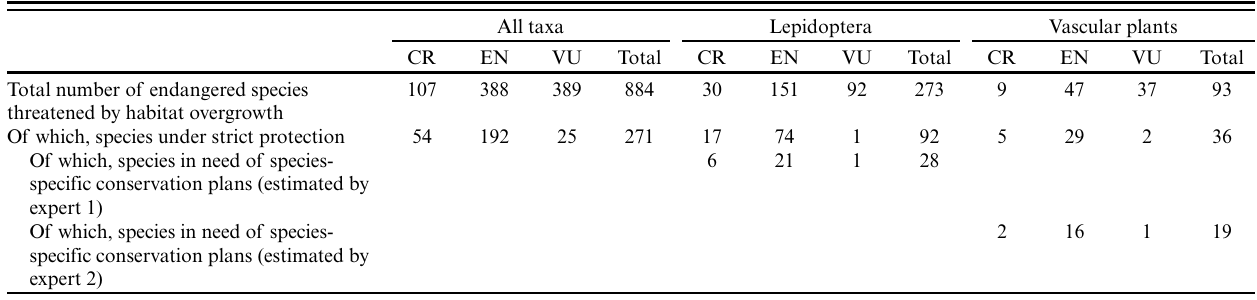
Table 1 . Numbers of endangered species in the Finnish Red List of Endangered Species 2010 (Rassi et al. 2010) in all taxa (left), in Lepidoptera (middle), and in vascular plants (right) for which the major cause of endangerment is habitat suffocation (threat code N), grouped according to their endangerment status: critically endangered (CR), endangered (EN), and vulnerable (VU). The table lists the numbers of species threatened by habitat overgrowth in the respective taxa that are classified as species under strict protection and would, based on the opinions of two taxon-specific experts, also require species-specific conservation plans like the false heath fritillary. All